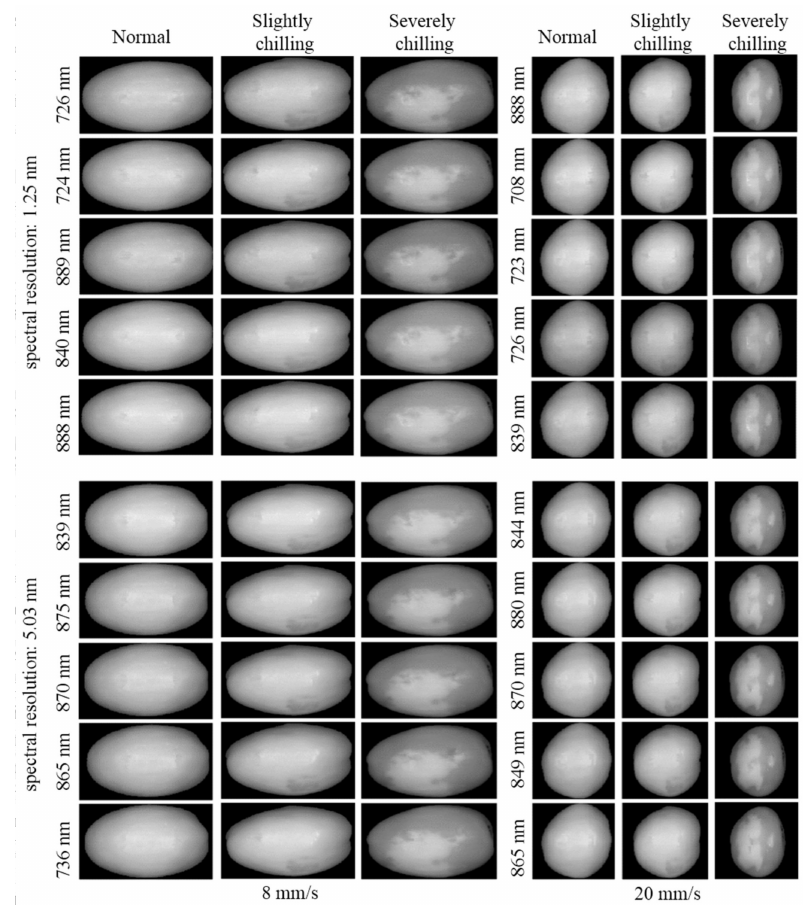
Figure 5. The first five selected spectral images of representative samples selected by Random frog at different scanning speeds and spectral